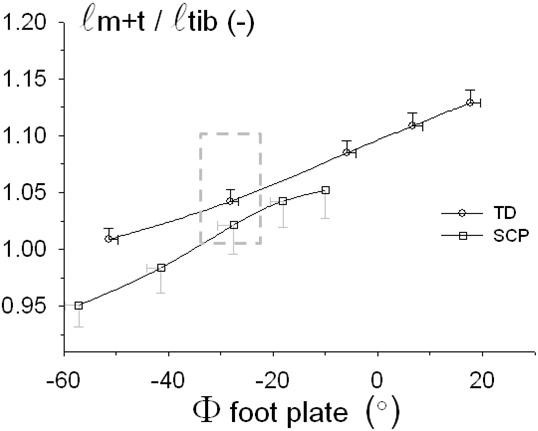
SCP-TD comparison: GM muscle tendon complex length. Length of the muscle-tendon complex (ℓm+t), normalized for tibia length, plotted as a function of foot plate angle. Mean values (and SE) and third-order polynomial fitted curves are shown. (φfoot plate) is represented as deviation from the neutral position (0°), i.e. with the longitudinal axis of the tibia perpendicular to the foot plate. Note that normalized length is even different for a point at similar foot plate angle (indicated by a dashed rectangle).